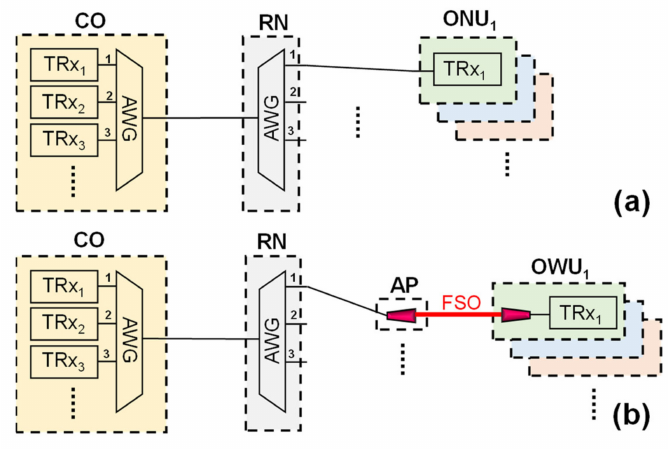
Figure 1. ( a ) Conventional WDM-PON system. ( b ) FSO transmission system integrated with WDM- PON.